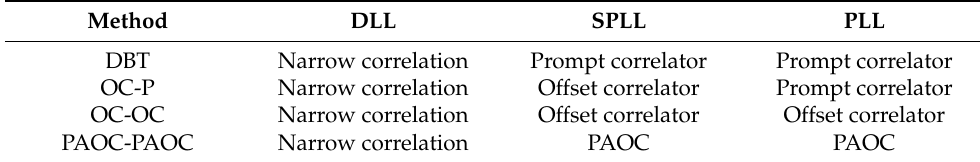
Table 1. Configurations of the four tracking methods for BOC signals. Method